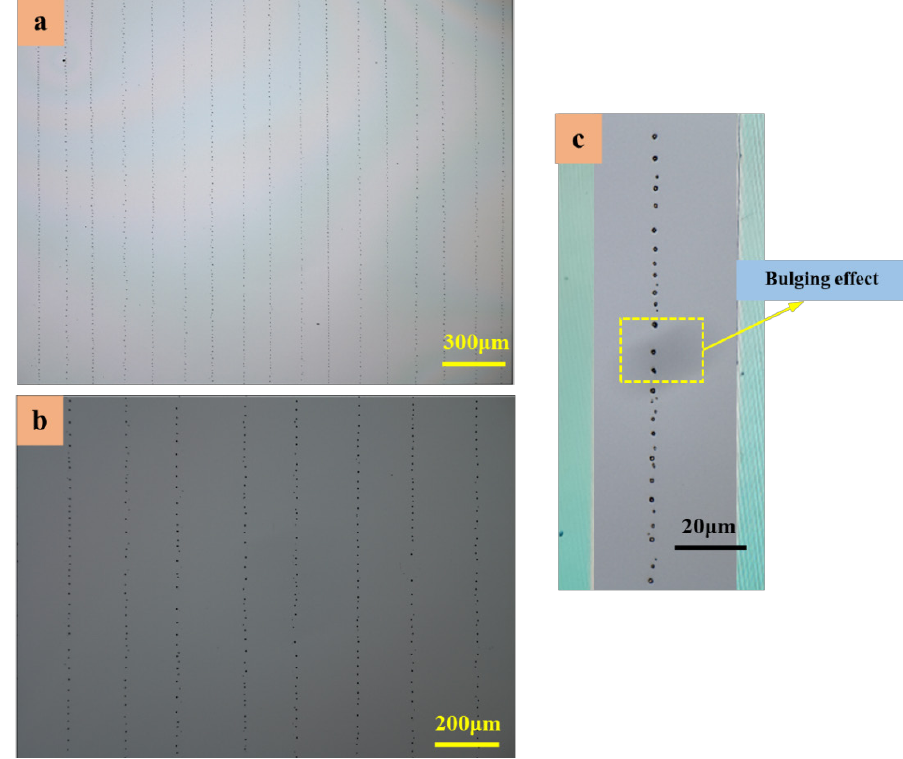
Figure 11. The printed droplets under different process parameters; ( a , b ) analysis of the coffee ring effect on the printed microdroplets keeping different distances between two dots; ( c ) the deposited microdroplets line on silicon substrate generating bulging effect.